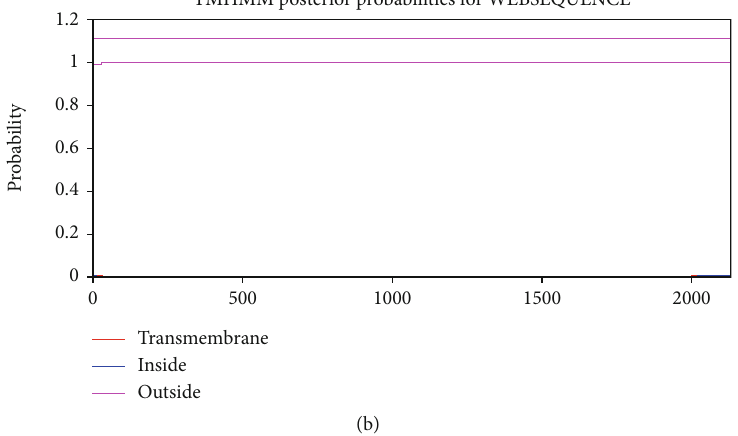
Figure 2: Transmembrane domains expected in CDPK7 protein. (a) Some statistics and a list of the location of the predicted transmembrane helices and the predicted location of the intervening loop regions. Length: the length of the protein sequence; number of predicted TMHs: the number of predicted transmembrane helices; Exp number of AAs in TMHs: the expected number of amino acids in transmembrane helices. If this number is larger than 18, it is very likely to be a transmembrane protein (or have a signal peptide); Exp number, fi rst 60 AAs: the expected number of amino acids in transmembrane helices in the fi rst 60 amino acids of the protein. If this number is more than a few, you should be warned that a predicted transmembrane helix in the N-term could be a signal peptide; total prob of N-in: the total probability that the N-term is on the cytoplasmic side of the membrane; (b) transmembrane domains expected in CDPK7 protein. (b) Analysis of the transmembrane domains of